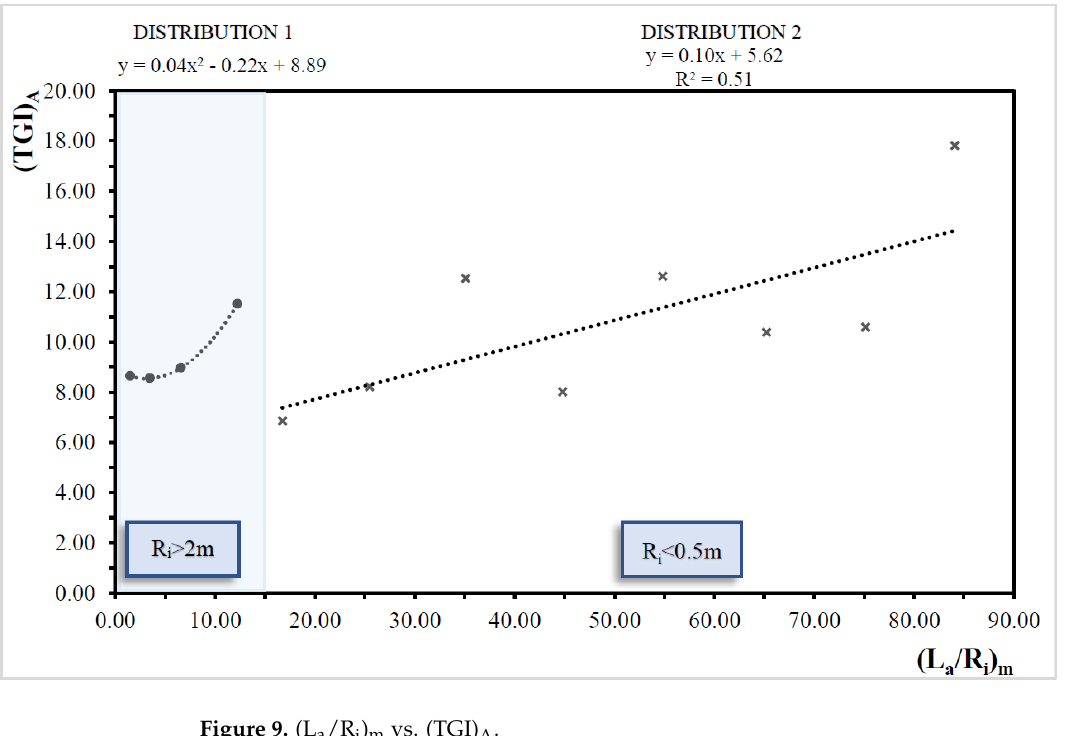
Figure 10 reports the trend of (L a ) m and (R i ) m for each distribution.